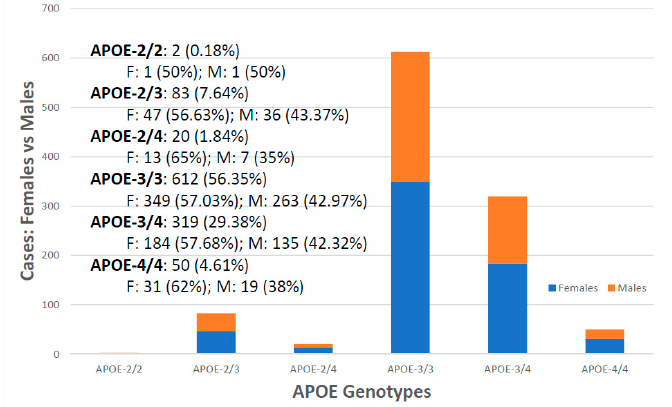
Figure 2. Sex-related differences in the distribution and frequency of APOE genotypes in Alzheimer’s disease.